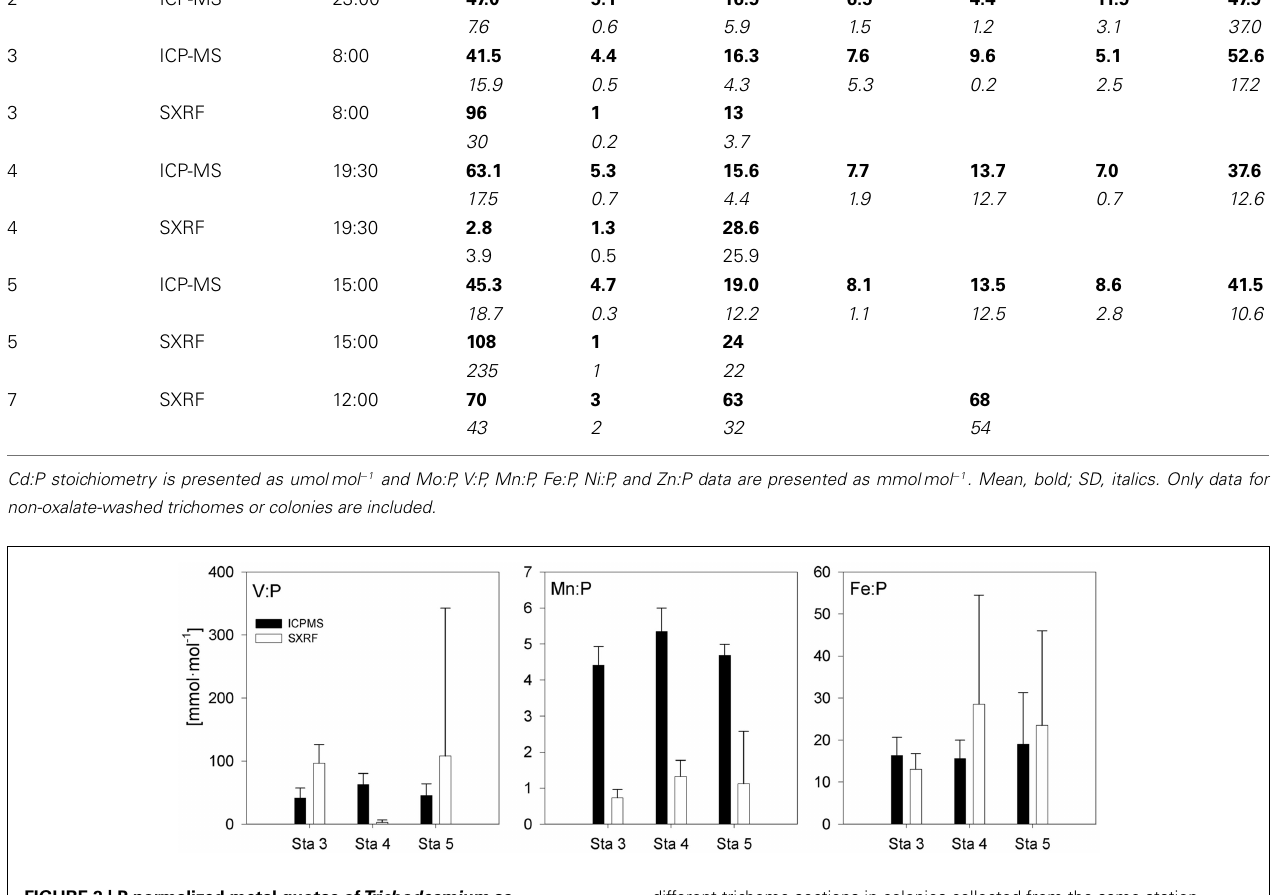
different trichome sections in colonies collected from the same station (SXRF). Only data for non-oxalate-washed trichomes and colonies are